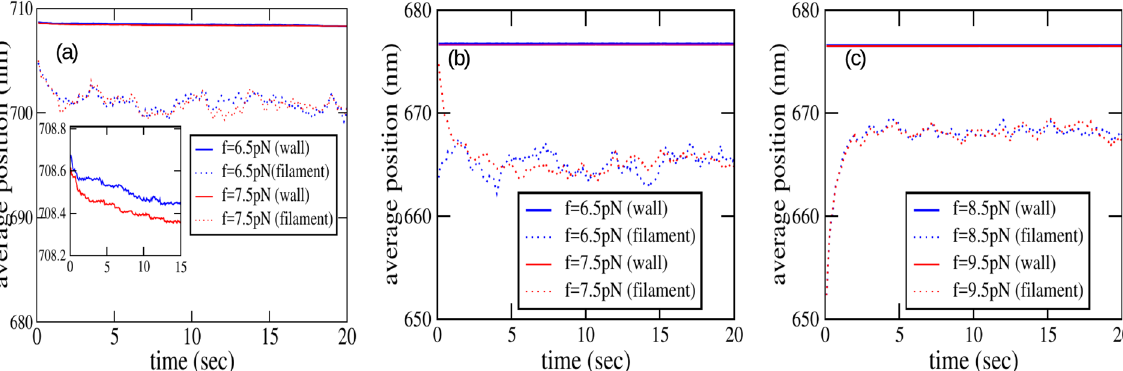
Figure 8. The time evolution of the average positions of the wall and one of the protofilaments is shown for ( a ) one microtubule, ( b ) two microtubules (near) and ( c ) two microtubules (far). In the inset of ( a ), the average position of wall alone shown. The parameters common for all the three cases are listed in Table 1. For two filaments, ‘near’ means zero base separation, while ‘far’ refers to a base separation 150 nm.